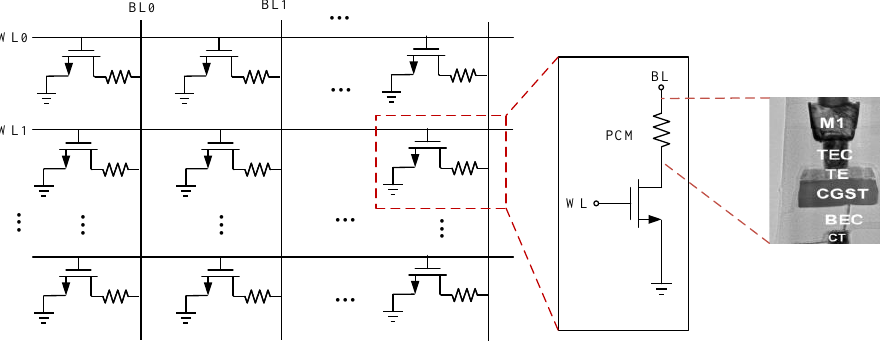
Figure 1. A circuit schematic of a memory cell with a phase change element.